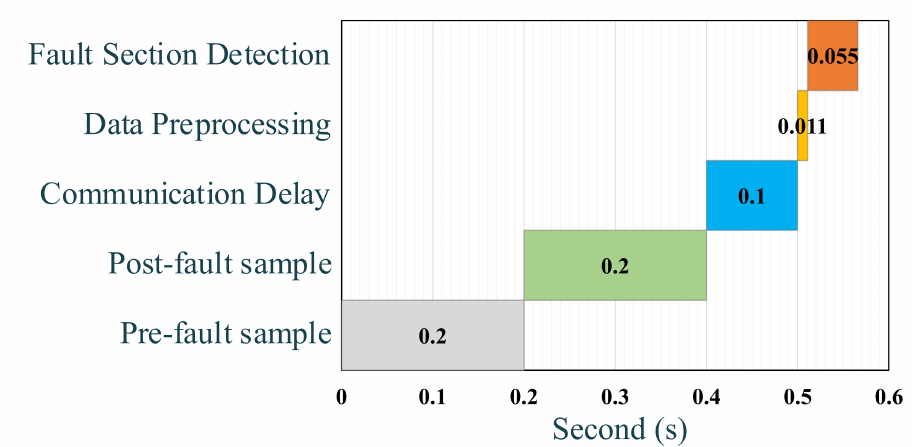
Figure 9. Fault section detection